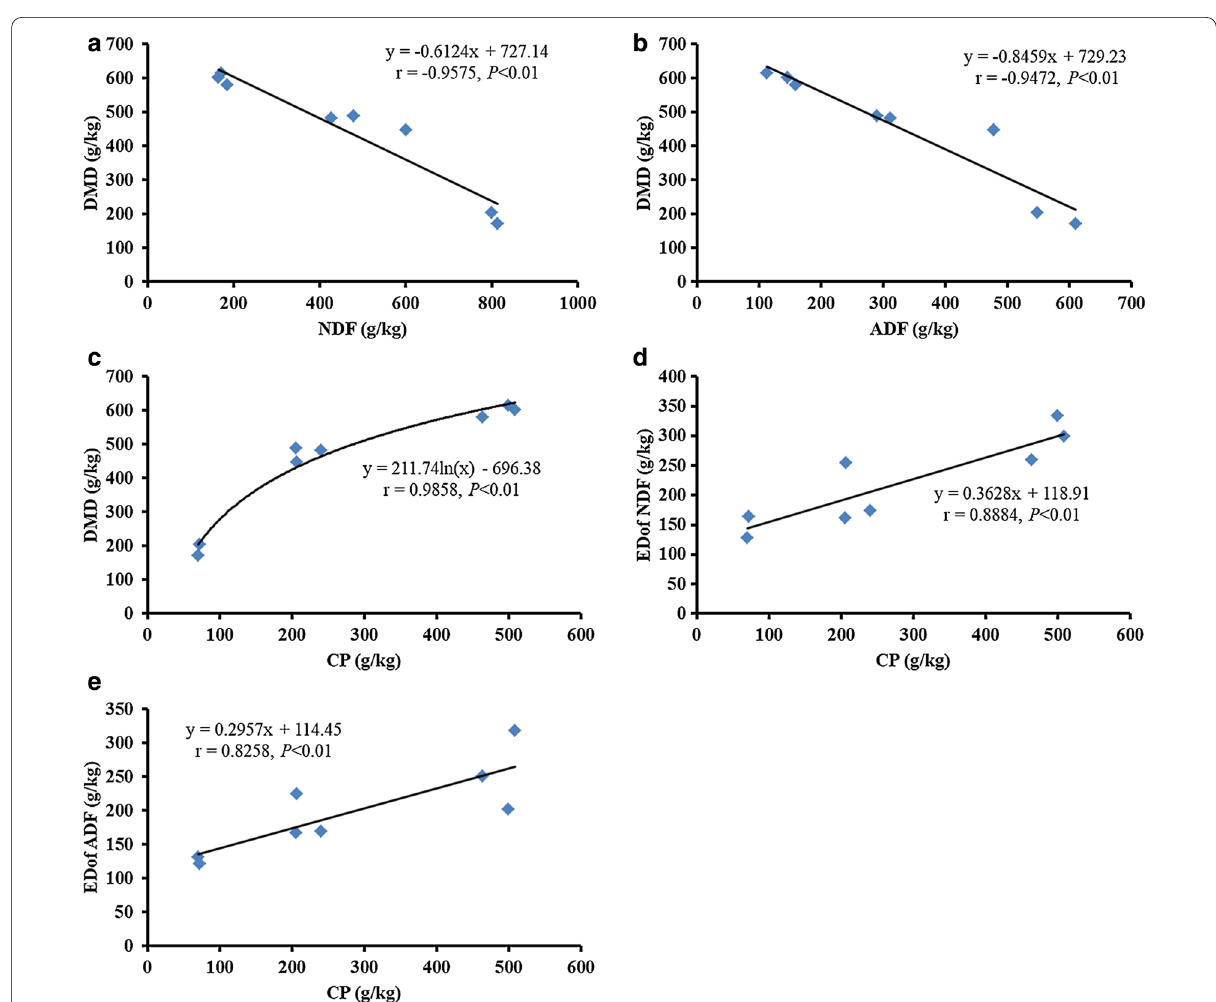
Fig. 3 Correlation analysis of chemical composition and rumen effective degradability of cotton by‑products. a correlation analysis of NDF content and ED of DM, b correlation analysis of ADF content and ED of DM, c correlation analysis of CP content and ED of DM, d correlation analysis of CP content and ED of NDF, e correlation analysis of CP content and ED of ADF